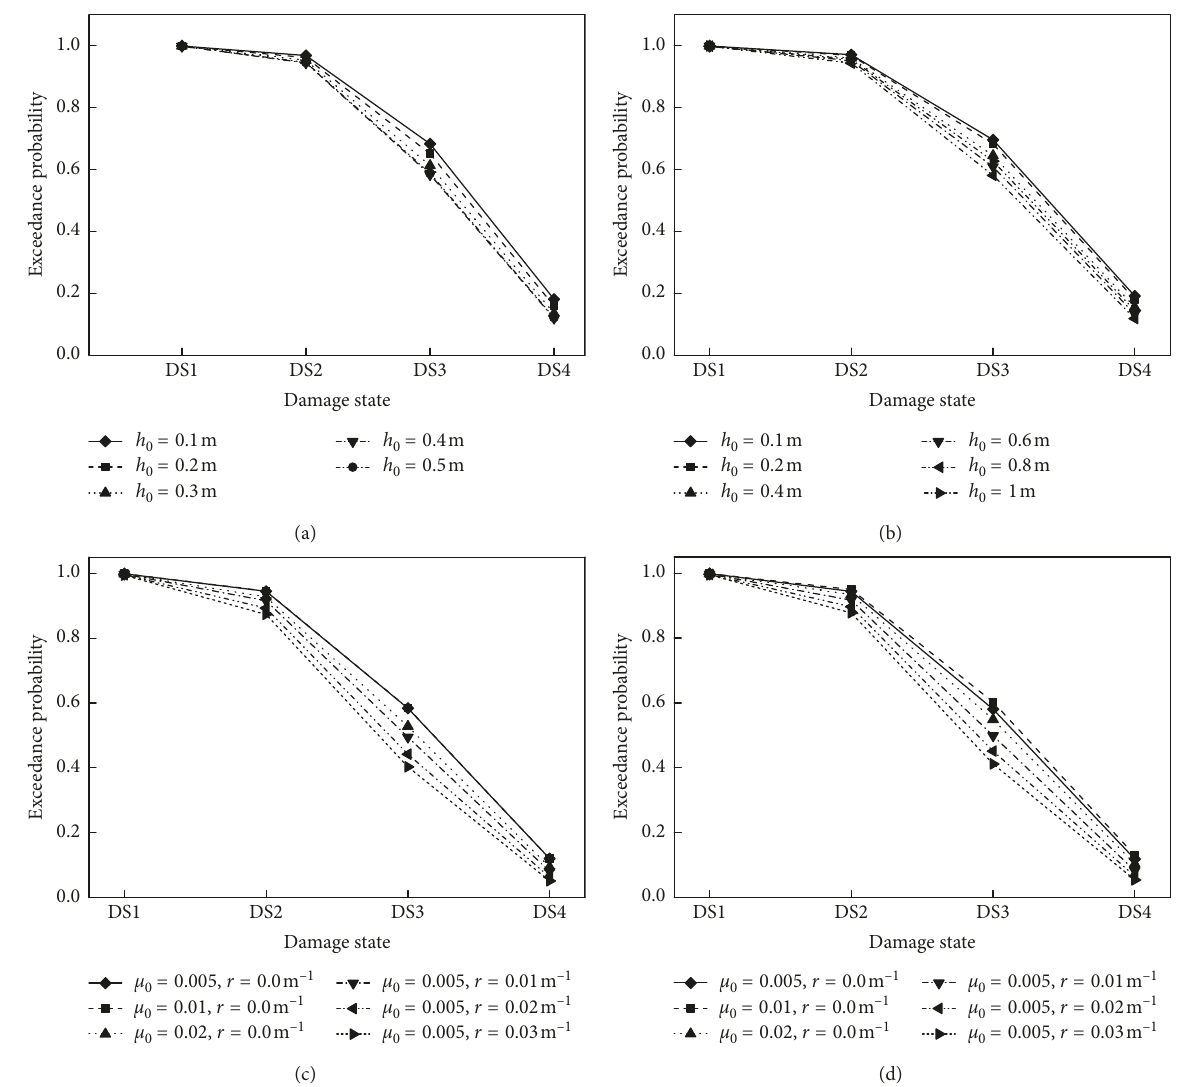
Figure 5: Structural peak relative displacement when K and DS4 are defined by the structural peak relative displacement in Table 2). (a) μ 0 . 0m. (c) h . 5m, h . 4m. (d) h h 1 (cid:31) 1 1 (cid:31) 0 0 (cid:31) 0